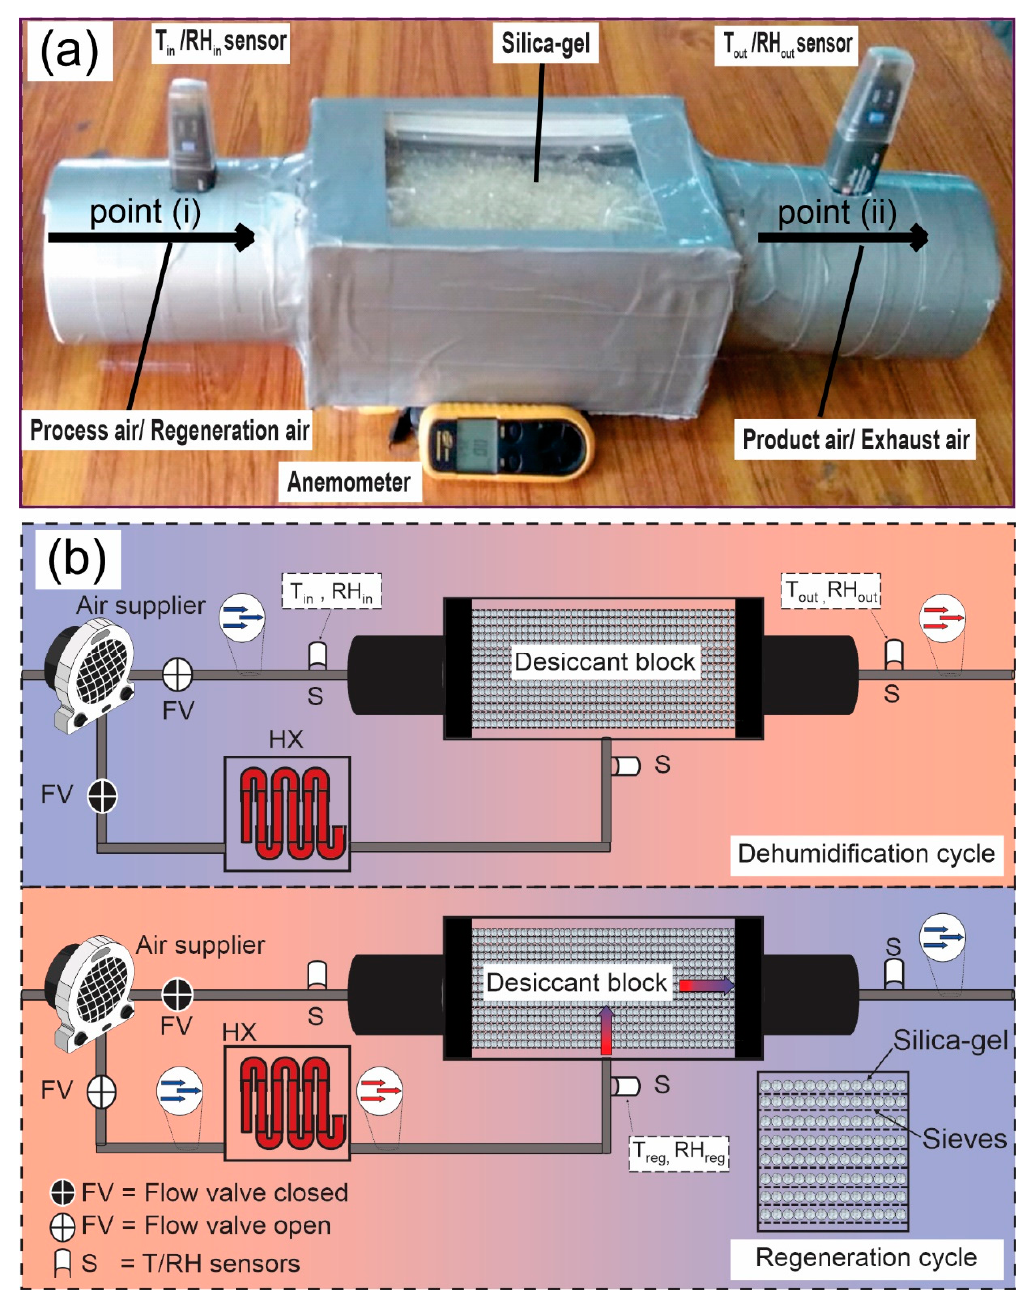
Figure 1. Pictorial representation of ( a ) the experimental system, and ( b ) schematic representation of the experimental system.